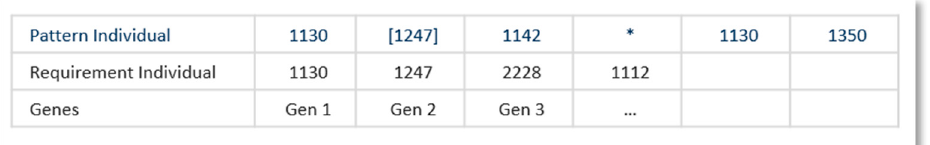
Figure 9. Genes and individuals (Requirements and Patterns). Asterisk represents a wildcard token as described in Section 3.1.5.